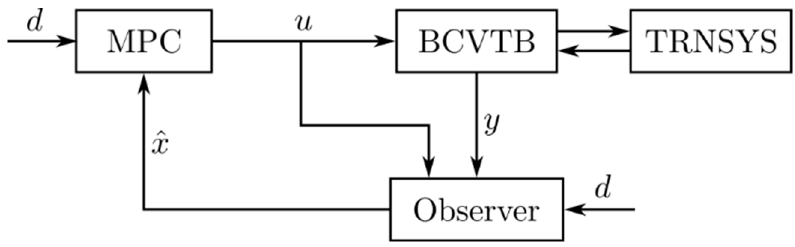
Figure 4. The general structure of the control loop for the